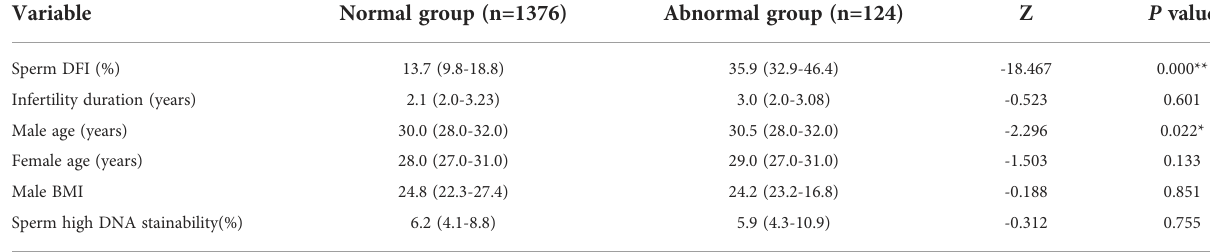
TABLE 2 Comparison of general data between the normal DFI group and abnormal DFI groups in IUI cycles. Variable